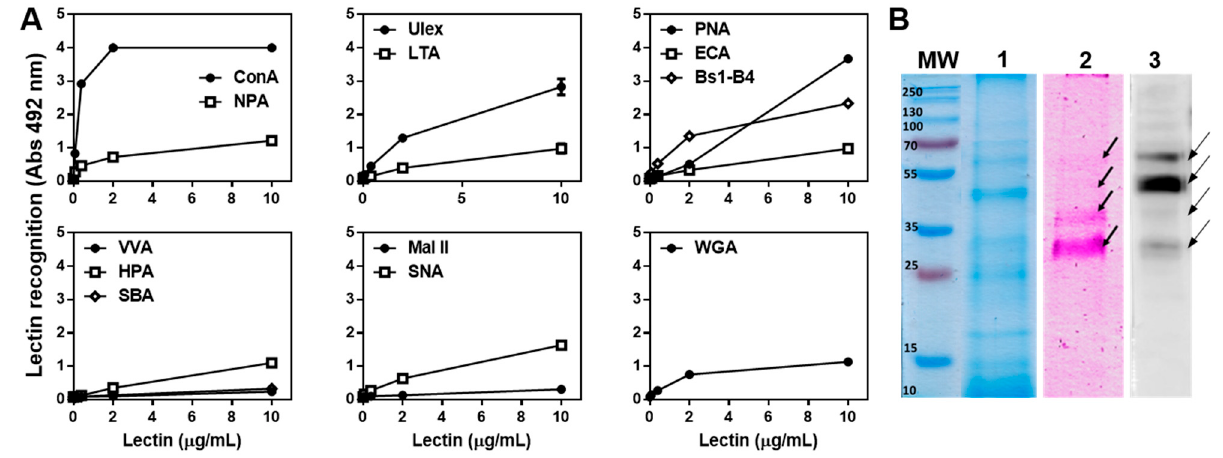
Figure 7. Glycoconjugates in T. cruzi lysate are recognised mainly by ConA: ( A ) Lectin recognition by Enzyme-linked Lectin assay. Reactivity by Helix pomatia lectin (HPA, specific for GalNAc), Vicia villosa lectin (VVL, recognising α / β GalNAc), Sambucus Nigra lectin (SNA, sialylated α 2,6Gal), Maackia amurensis II lectin (MAL II, sialylated α 2,3Gal),), Dolichos biflorus agglutinin (DBA, GalNAc), Soybean Agglutinin (SBA, α / β GalNAc), Bandeiraea simplicifolia lectin isolectin B4 (BS1-B4, α GalNAc), Peanut Agglutinin (PNA, with Gal β (1,3)GalNAc specificity), Wheat Germ Agglutinin (WGA, recognising GlcNAc in poly- N -acetyllactosamine repeats), Concavalin A (ConA, specific for Glc and Man in N-glycans), Narcissus pseudonarcissus agglutinin (NPA, α Man), Ulex Europaeus I (Ulex, α 1,2-Fuc), Lotus Tetragnolobus agglutinin (LTA, α L-Fuc) was determined. ( B ) T. cruzi epimastigote lysate was run on 12% SDS polyacrylamide gels and stained either with Coomassie brilliant blue G-250 (lane 1) and with the GlycoPro glycoprotein staining kit (lane 2). Alternatively, proteins in gels were transferred to a nitrocellulose membrane and incubated with biotinylated ConA (0.4 µg/mL) (lane 3). Representative results from at least two independent experiments are shown. Arrows indicate several components visualised by the GlycoPro glycoprotein staining kit (lane 2) and by ConA recognition (lane